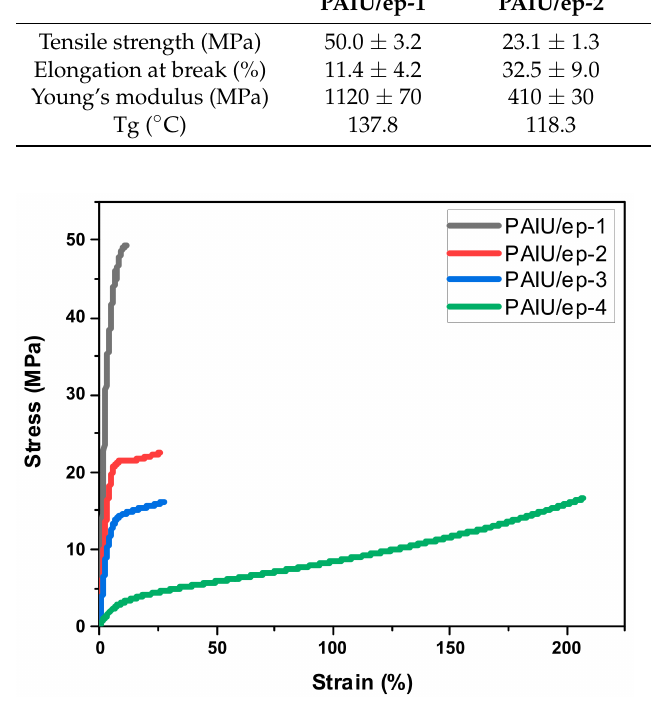
Figure 3. Stress-strain curves of PAIU/epoxy